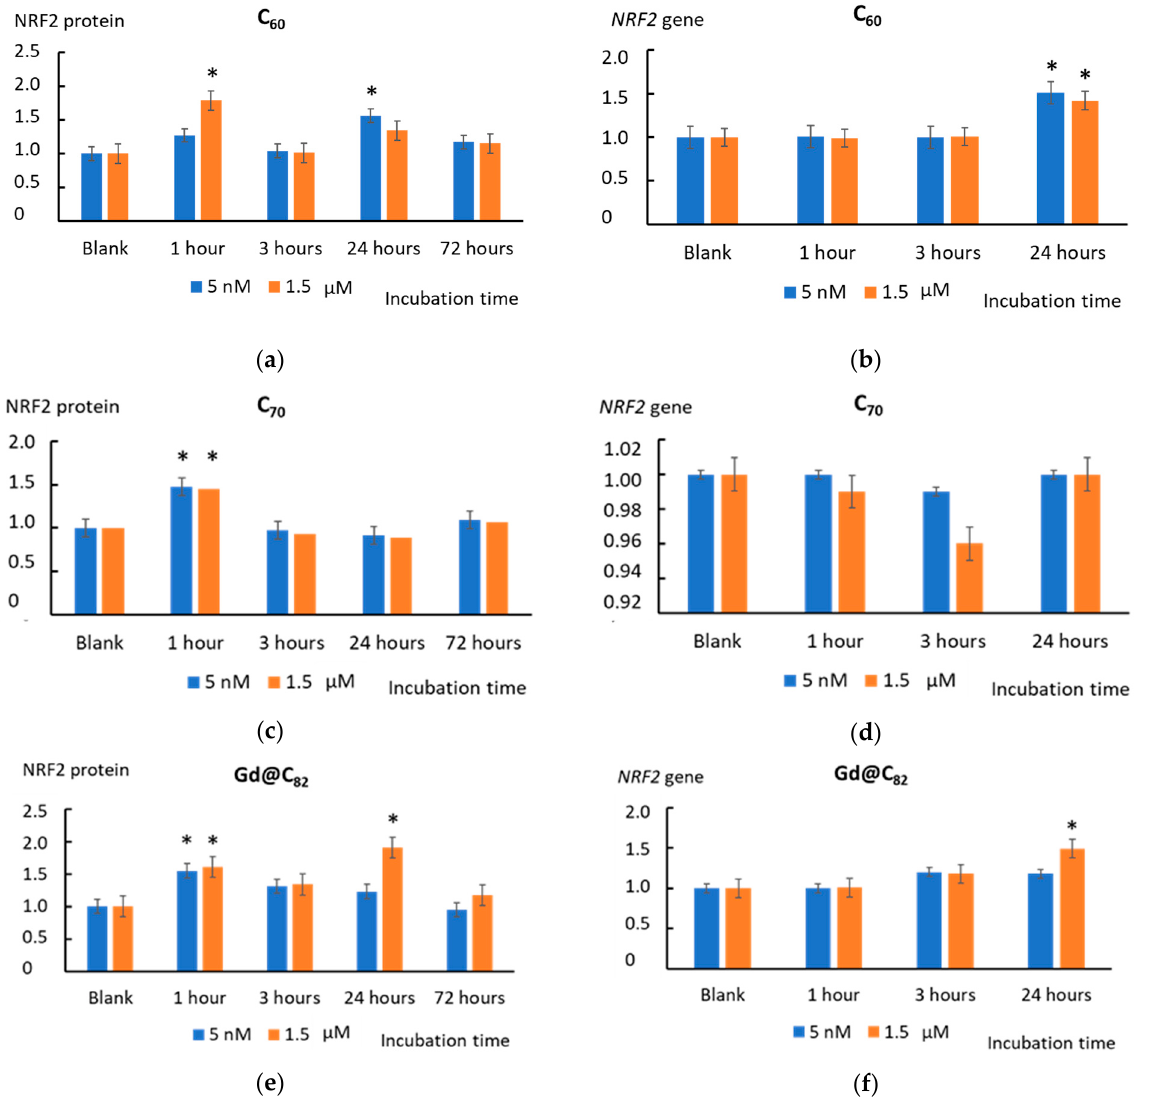
Figure 10. The NRF2 protein level in the cells treated with ( a ) C 60 , ( c ) C 70 , and ( e ) Gd@C 82 at concentrations of 5 nM and 1.5 µM related to the blank cells incubated without the AFDs. The expression of the NRF2 gene in cells incubated with ( b ) C 60 , ( d ) C 70 , and ( f ) Gd@C 82 at concentrations of 5 nM and 1.5 µM. The NRF2 RNA level is the mean from three replicates related to the NRF2 gene expression in the blank cells. The TBP gene was used as an internal-standard gene. (*) denotes significant differences with the blank cells, p < 0.01, a nonparametric U-test.